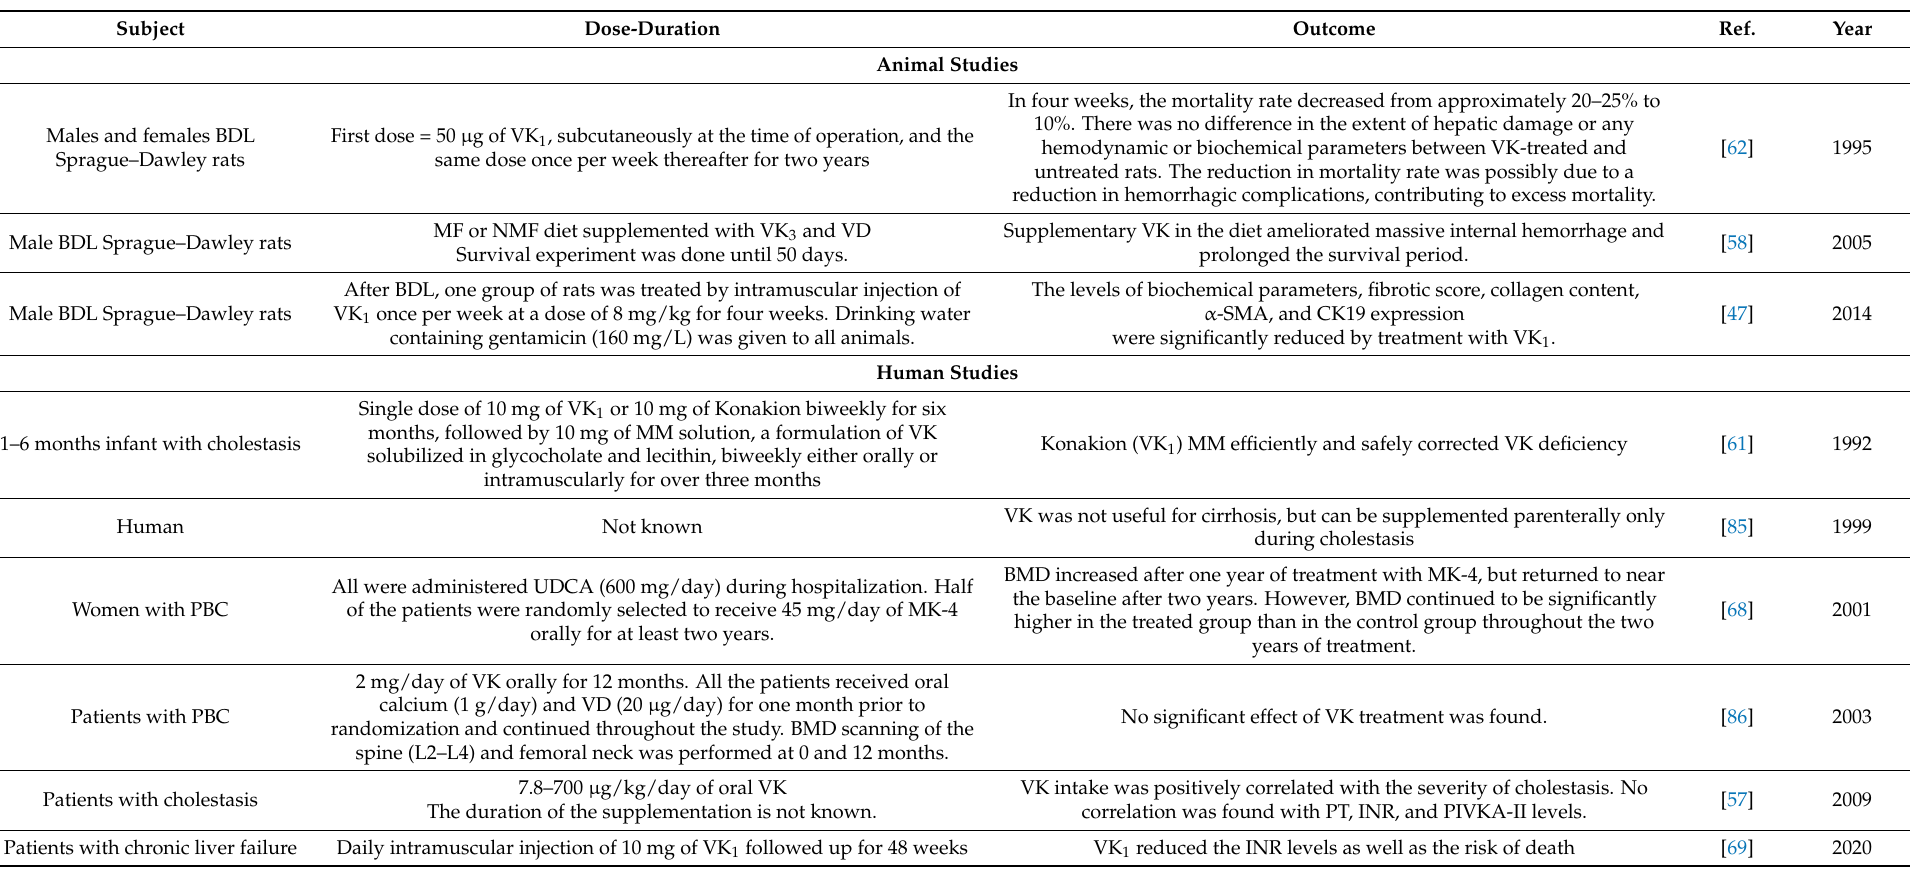
Table 1. Supplementation of vitamin K in cholestatic liver